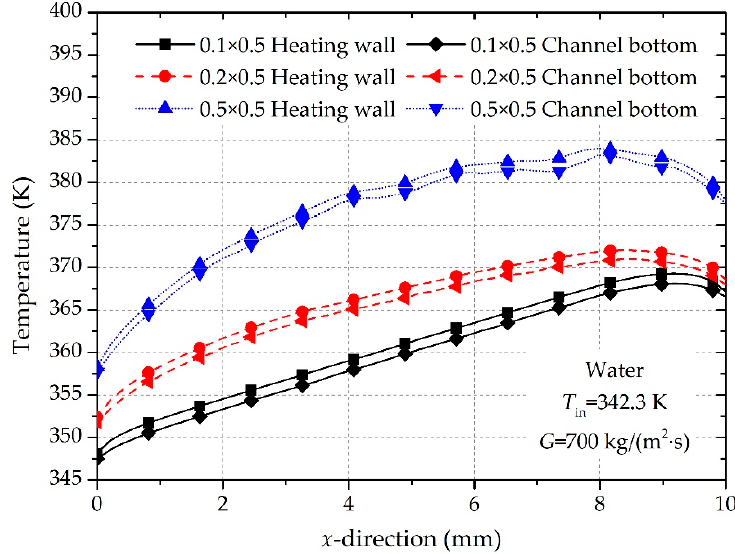
Figure 15. Temperature distribution of the heating wall and the channel bottom wall along the flow direction for different channel widths.